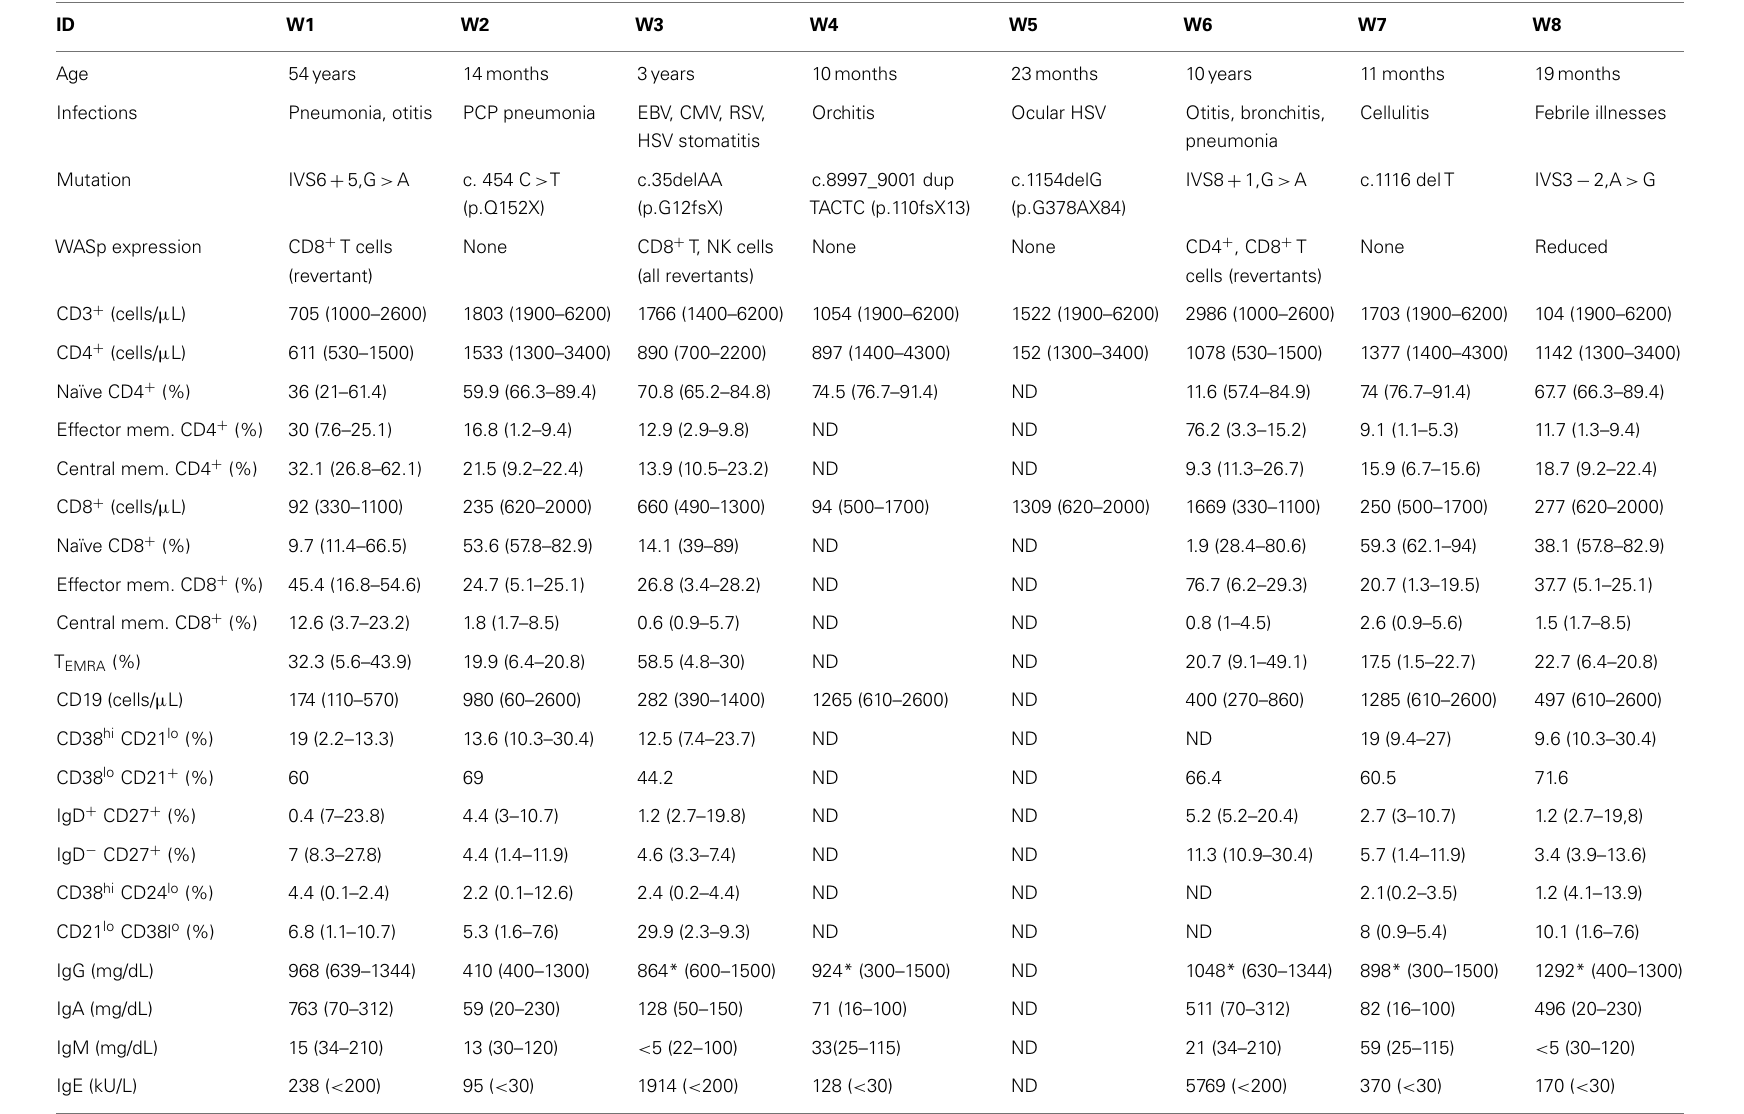
Table 1 | Patient characteristics